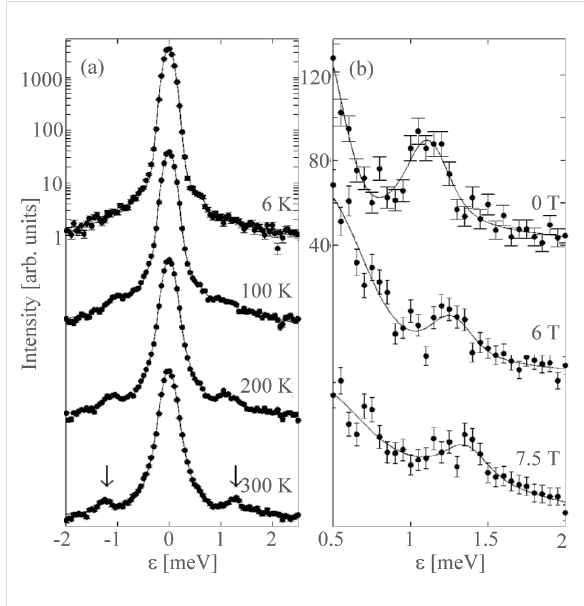
Figure 6: Inelastic neutron scattering data for 15 nm hematite parti- cles measured at the scattering vector Q = 1.50 Å − 1 : (a) Data obtained in zero applied magnetic field at the indicated temperatures; (b) data obtained at 200 K with the indicated applied magnetic fields. [Reprinted from Klausen, S. N.; Lefmann, K.; Lindgård, P.-A.; Kuhn, L. T.; Frandsen, C.; Mørup, S.; Roessli, B.; Cavadini, N. Quantized spin waves and magnetic anisotropy in hematite nanoparticles. Phys. Rev. B 2004 , 70 , 214411. Copyright (2004) by the American Physical Society.]